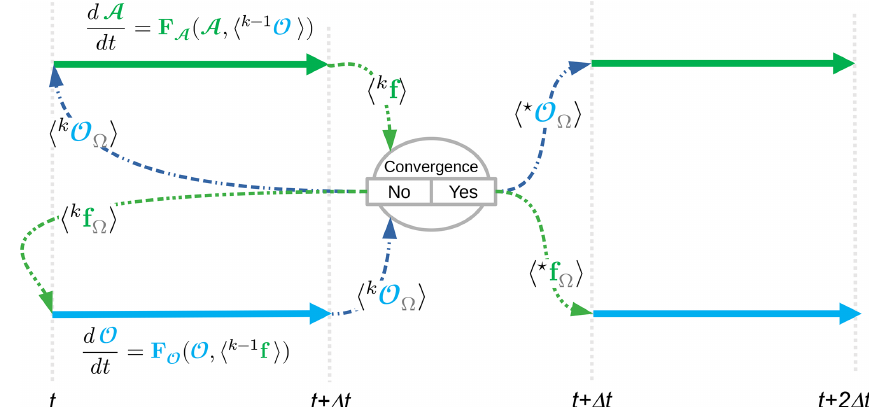
Figure 2. Stencil of the Schwarz iterative method, shown for the parallel algorithm; k is the iteration index. The (cid:63) superscript denotes the converged solution. At each iteration k , the first guesses of A and O at time t are taken from the states of A and O at the end of the previous Schwarz window [ t − (cid:49)t,t ] and for the last iteration. Only the boundary conditions are updated at each iteration.